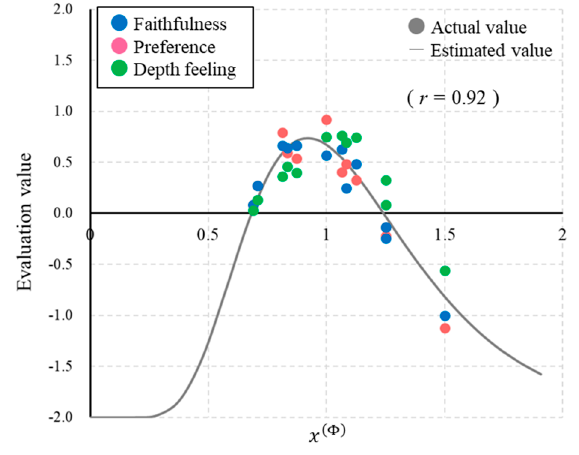
Figure 7. Fitting result by proposed common estimation model.